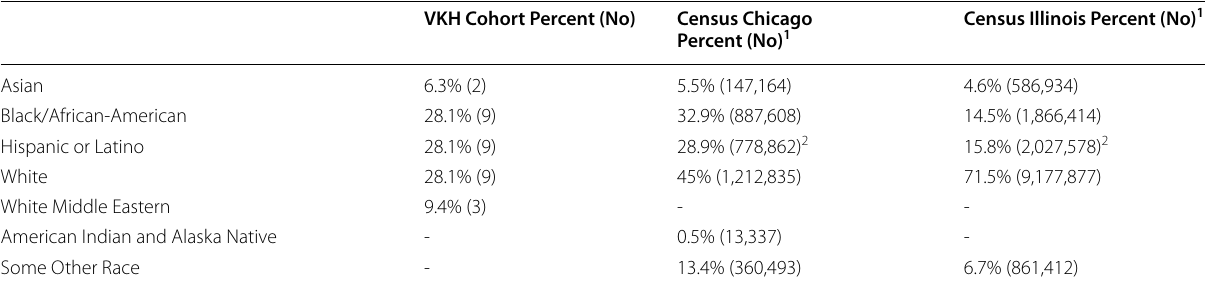
Table 1 Racial and ethnic distribution of our cohort and the U.S. Census data. 1 Results from the 2010 census by the U.S. Census Bureau. 2 Hispanic or Latino origin among all the races